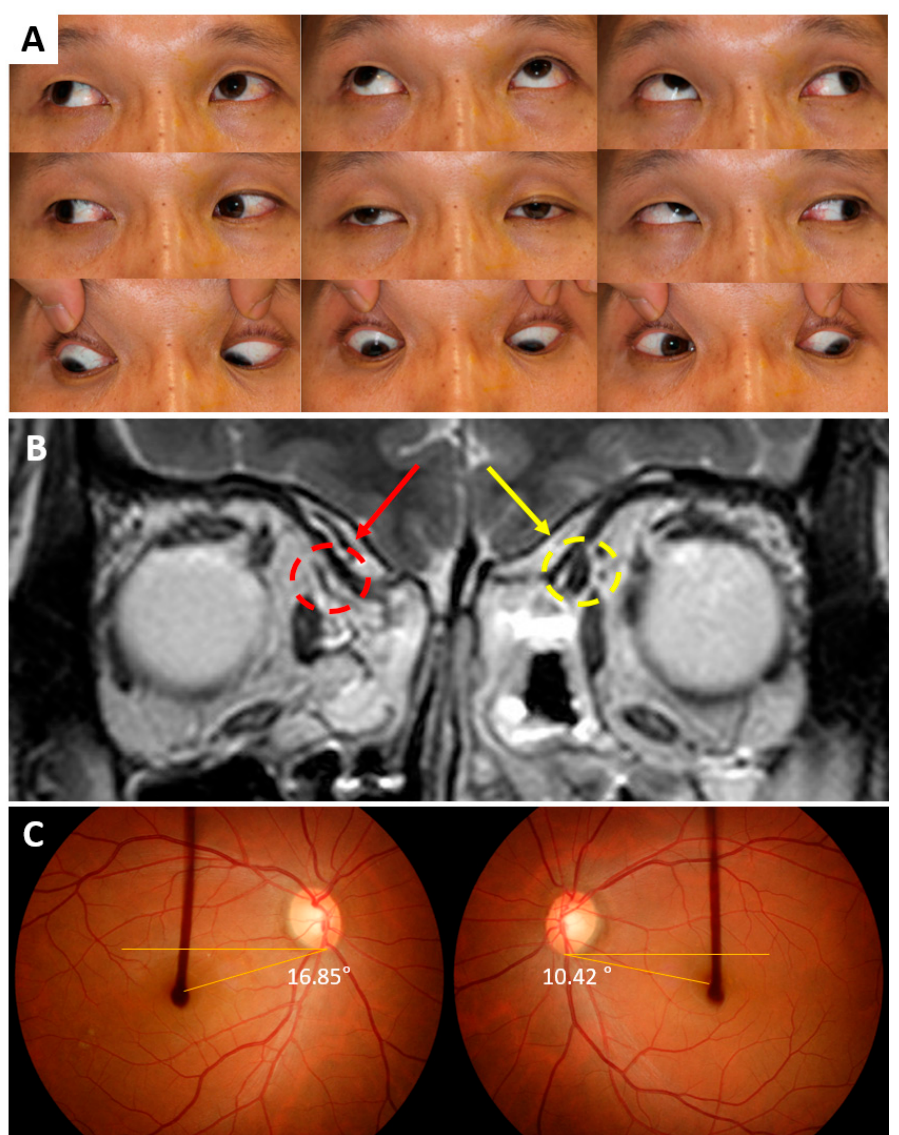
Figure 1. A representative case of a 45-year-old man with unilateral right superior oblique palsy and bilateral fundus excyclotorsion. ( A ) Ocular versions demonstrating increased elevation and decreased depression in adduction of the right eye. ( B ) The right superior oblique muscle is hypoplastic (red arrow) compared with the left (yellow arrow). ( C ) Bilateral fundus excyclotorsion on fundus photographs taken with an internal fixator. Single angle measurements are indicated in both eyes.